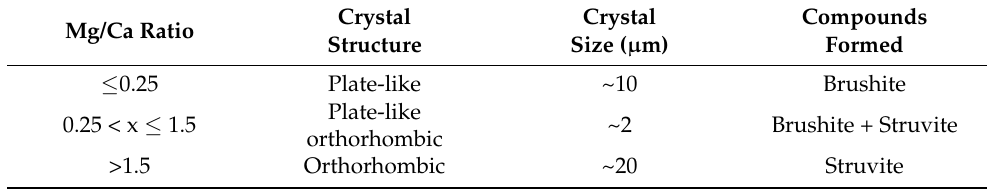
Table 4. Phase evolution, crystal size and structure as function of Mg/Ca molar ratio in solution. Mg/Ca Ratio ≤ 0.25 Plate-like ~10 Brushite 0.25 < x ≤ 1.5